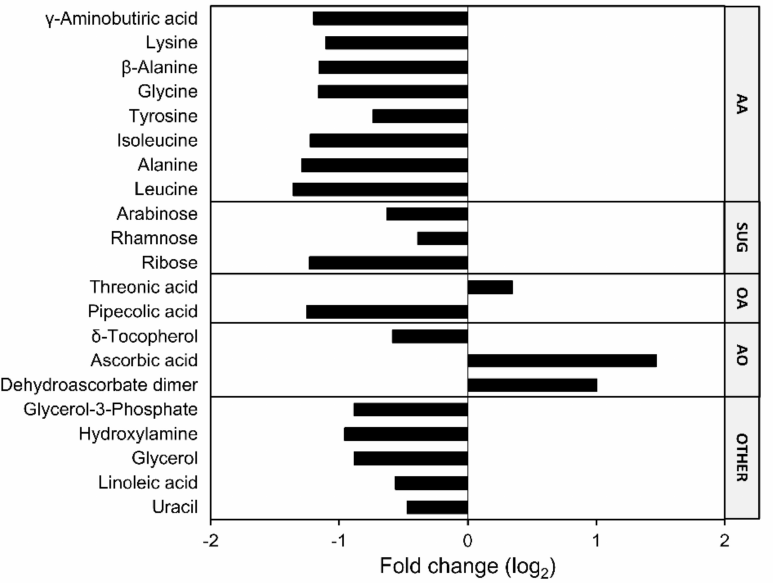
Figure 6. Low-molecular-weight metabolites with differential changes ( p < 0.05, t -tests) in dry seeds of an insertional mutant line (fumarylacetoacetate hydrolase domain-containing protein 1a, Atfahd1a- 1 ) in relation to the wild type (WT, ecotype Columbia-0). Average metabolite concentrations detected in Atfahd1a-1 seeds were divided by those measured in the WT, and fold-changes of individual metabolites were expressed as log 2 . Data are means ( n = 4) of individual metabolites detected by gas chromatography coupled to mass-spectrometry-based metabolite profiling of seeds collected from individual plants of the first plant generation for each line. Metabolites are grouped in biochemical classes: AA, amino acids; SUG, sugars; OA, organic acids; AO, antioxidants. All identified metabolites showing non-significant changes between the two seed lines ( p ≥ 0.05, t -tests) are listed in Table